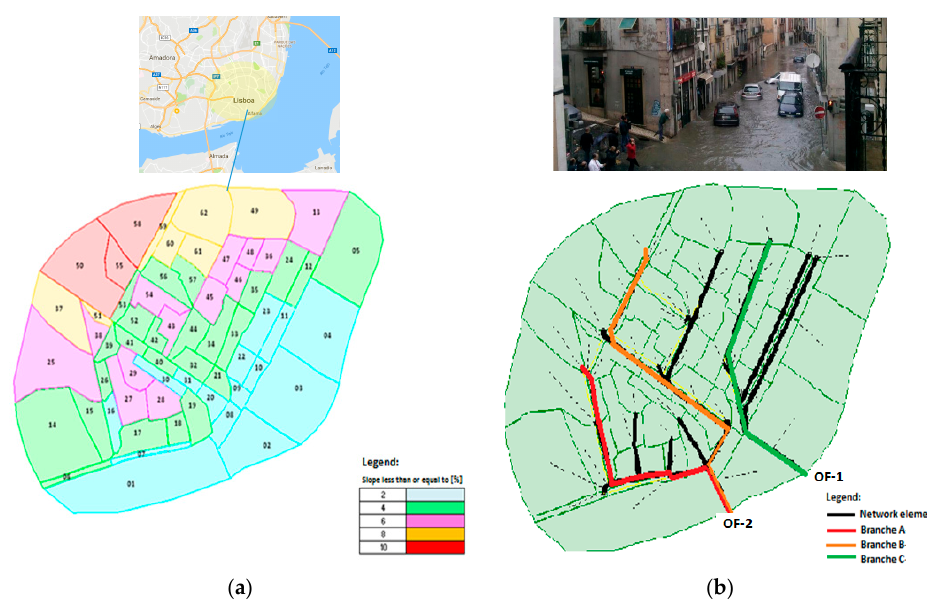
Figure 4. Studied area, flood event and identification of sub-basins for the simulation model and level of slopes ( a ); and the network of the storm drainage system ( b ). Table 2. Summary of main characteristics of the basin.